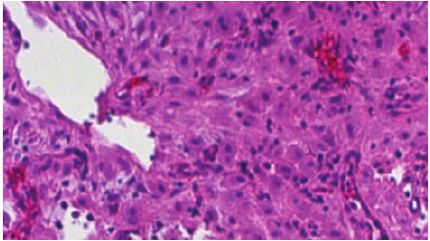
Figure 3: Hematoxylin-eosin stained sections of the left ovary; endometrial glands and decidualized areas are shown.